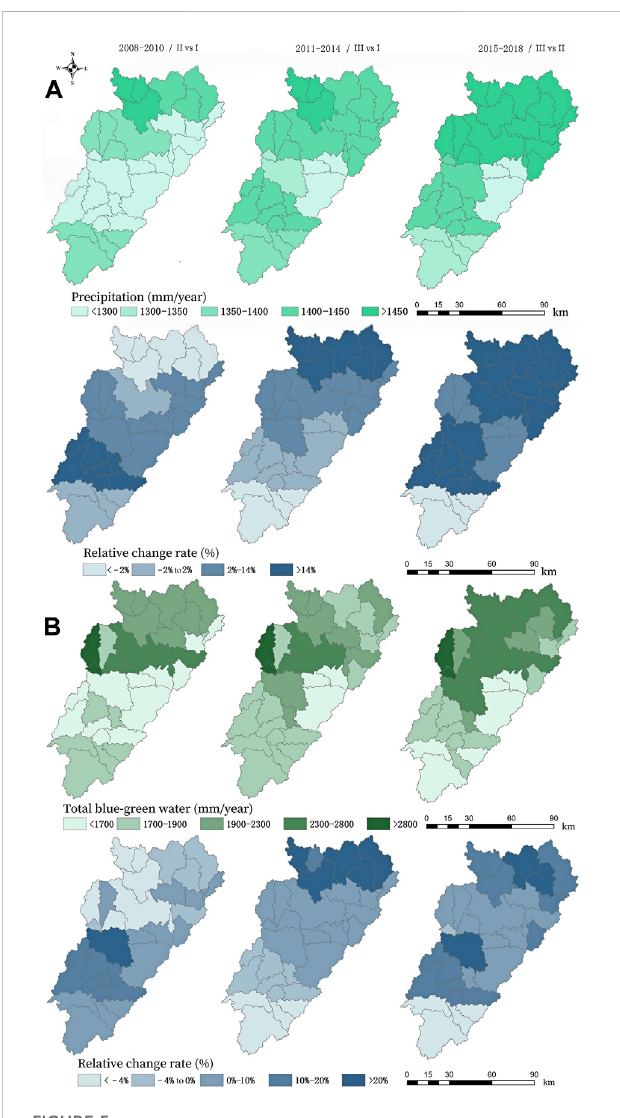
FIGURE 5 Spatial distribution of precipitation, total blue and green water, and relative rates of change in the Meijiang River Basin. (A) Precipitation and relativeratesofchange; (B) Totalbluewaterandgreenwaterandrelative rates of